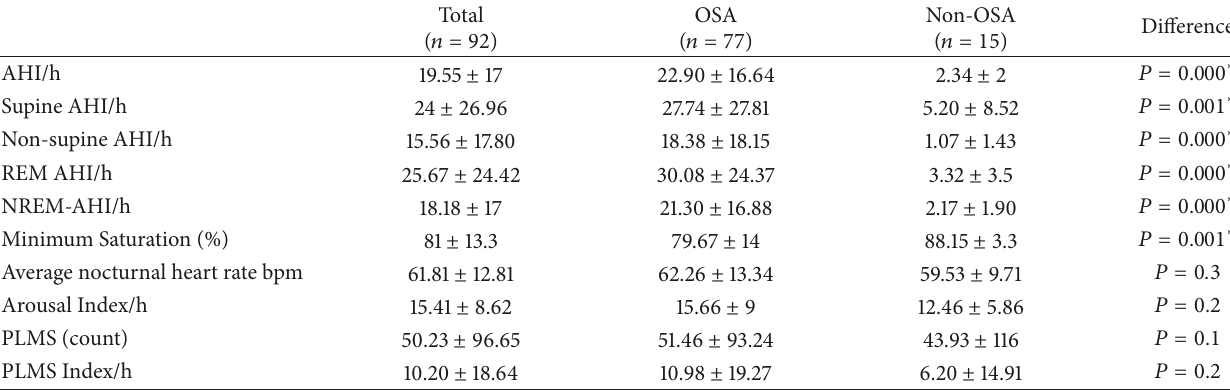
Table 2: Respiratory and other sleep parameters for the study sample during first night of ambulatory sleep testing.